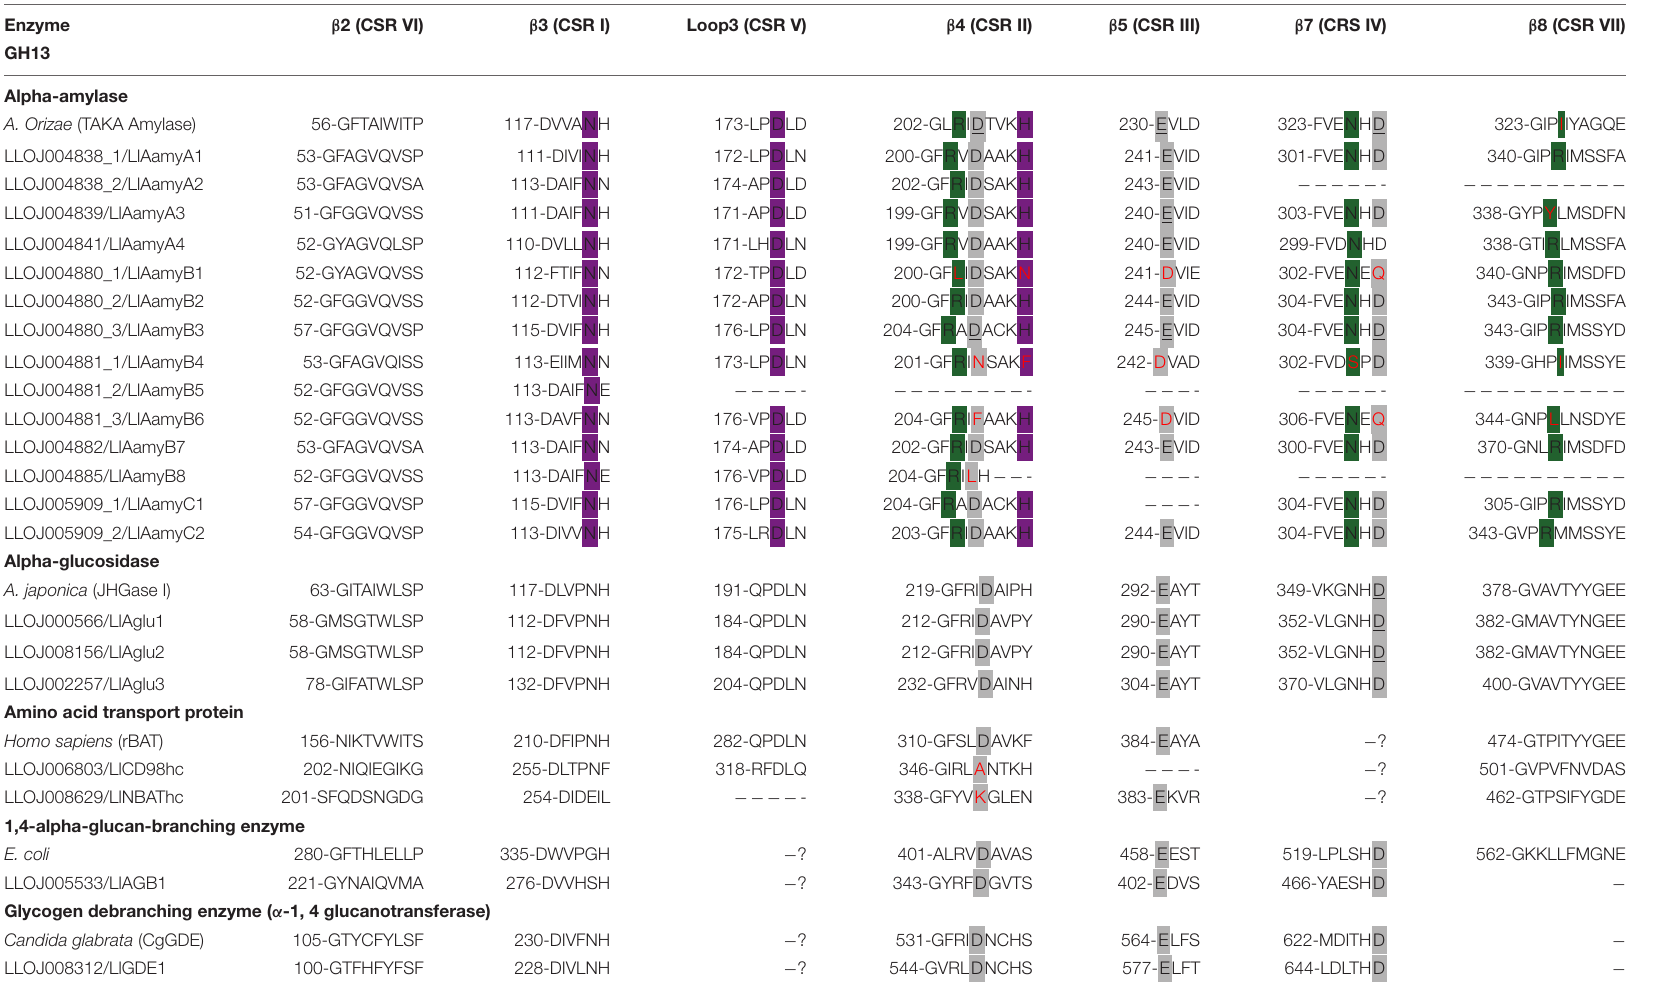
TABLE 1 | Conserved amino acid sequences in proteins belonging to GH13.